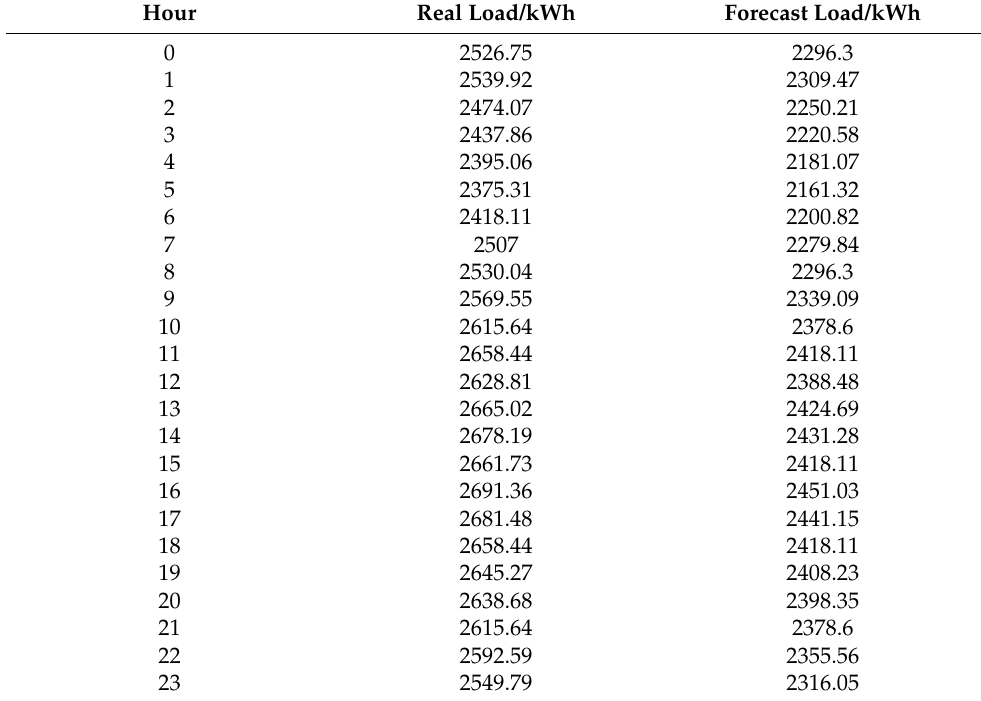
Table A3. Consumer typical load in Guangdong province.